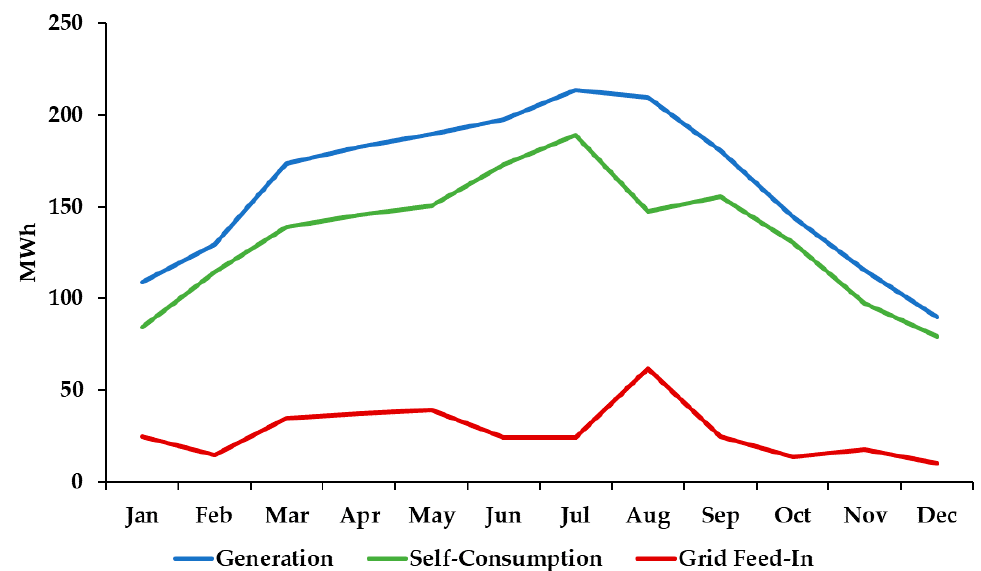
Figure 5. Variation of the PV generation, self-consumption and grid feed-in. Table 5. Distribution of PV energy and consumption (scenario with energy storage)